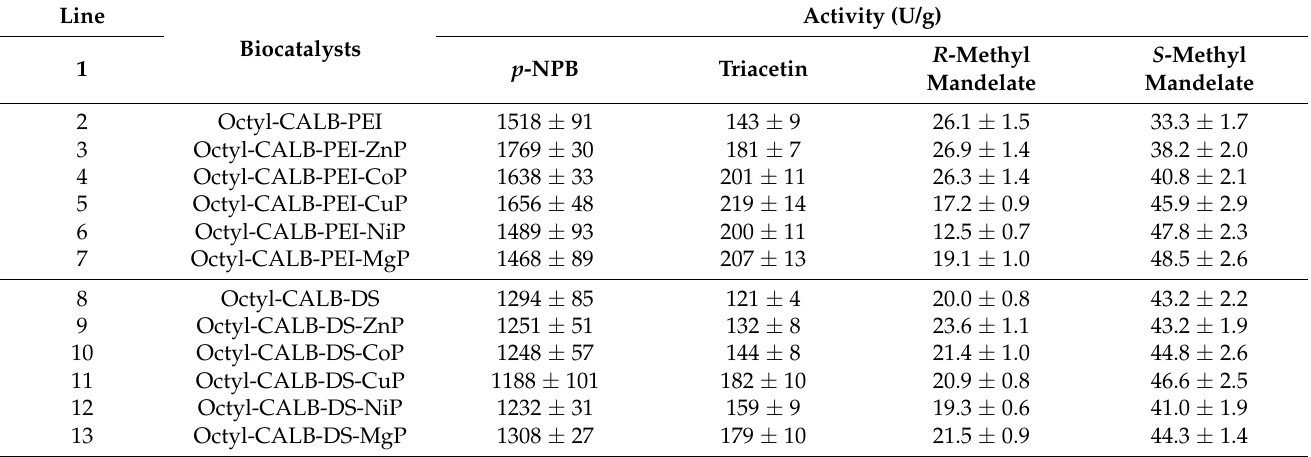
Table 8. Specific activity of different immobilized and physically modified CALB biocatalysts after solid-phase mineralization. The hydrolytic activity was measured using 1 mM p -NPB (pH 7